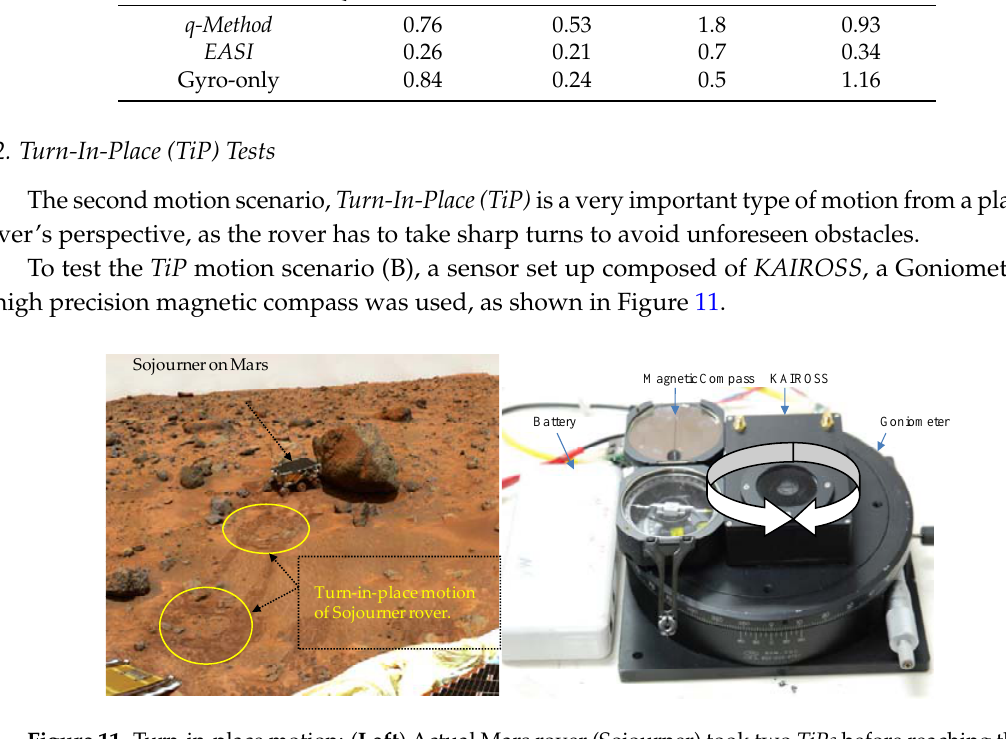
Figure 11. Turn-in-place motion: ( Left ) Actual Mars rover (Sojourner) took two TiPs before reaching the targeted rock [30]; ( Right ) Sensors set-up for TiP test (B), both CCW and CW rotation through 0–360°.